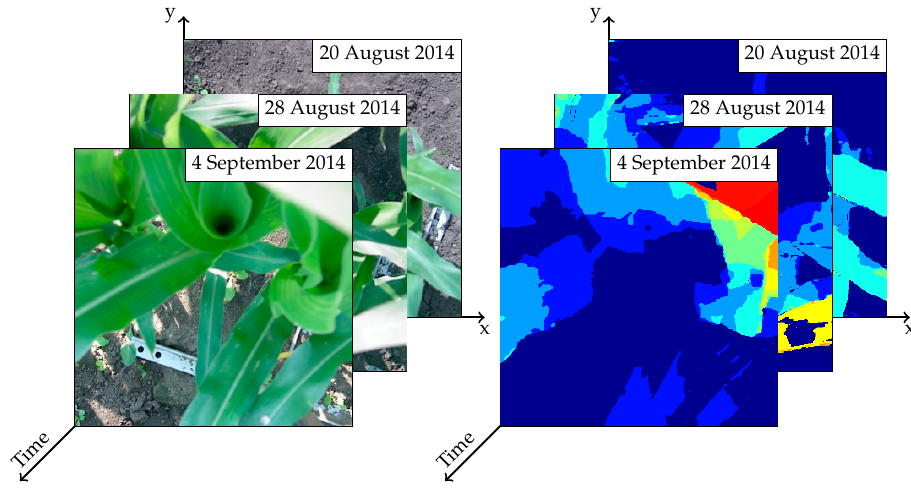
Figure 16. Time lapse animations or time series of the acquired depth maps allow an impressive insight into the plant growth and growth dynamics of the